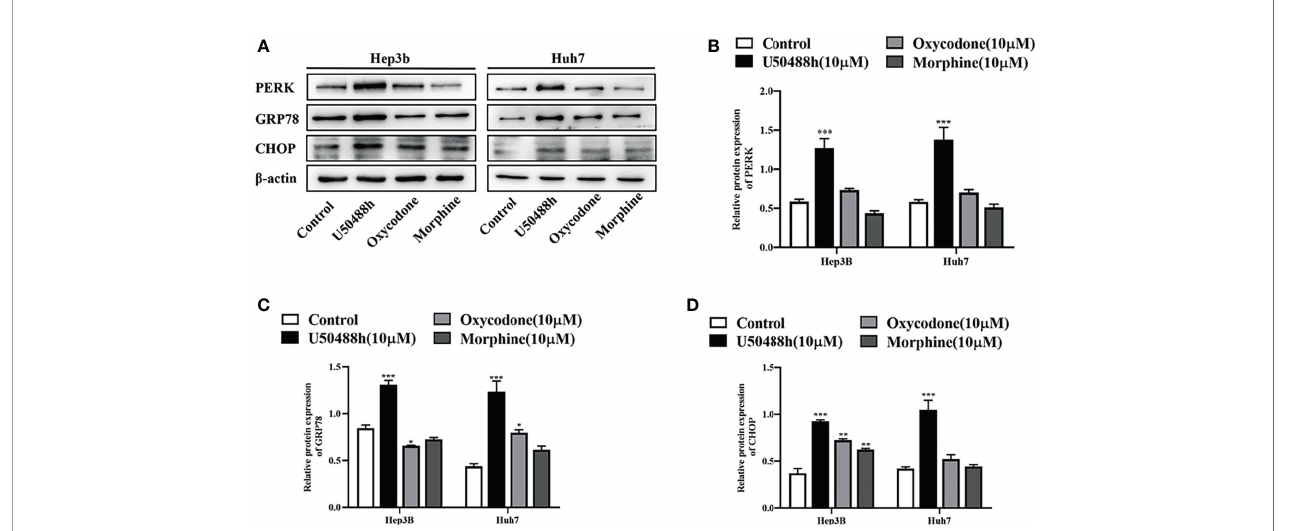
FIGURE 5 | KOR agonist induced endoplasmic reticulum (ER) stress in HCC cells. HCC cell lines Hep3B and Huh7 incubated with U50488h (10 m M), oxycodone (10 m M) and morphine (10 m M) for 48 h, ER stress-related mRNAs and proteins including GRP78, PERK, and CHOP were detected by RT-qPCR (S1) and Western blotting (A – D) . b -actin was used as an internal control. Values are reported as the mean ± standard deviation (n = 3). *P < 0.05, **P < 0.01, ***P < 0.001 vs. control